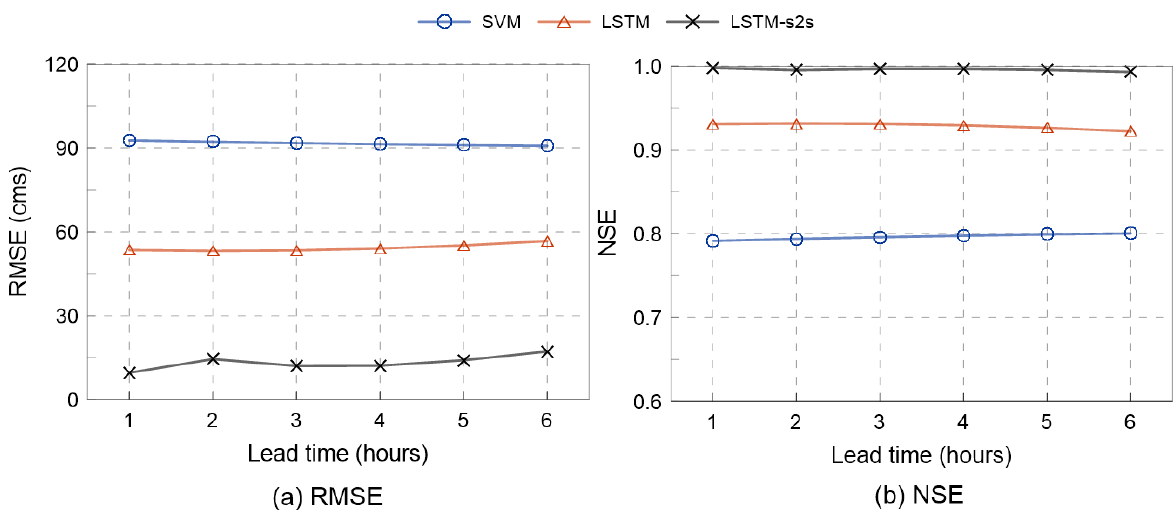
Figure 6. Statistical metrics with lead times from 1 to 6 h. ( a ) and ( b ) show the results of RMSE and NSE.